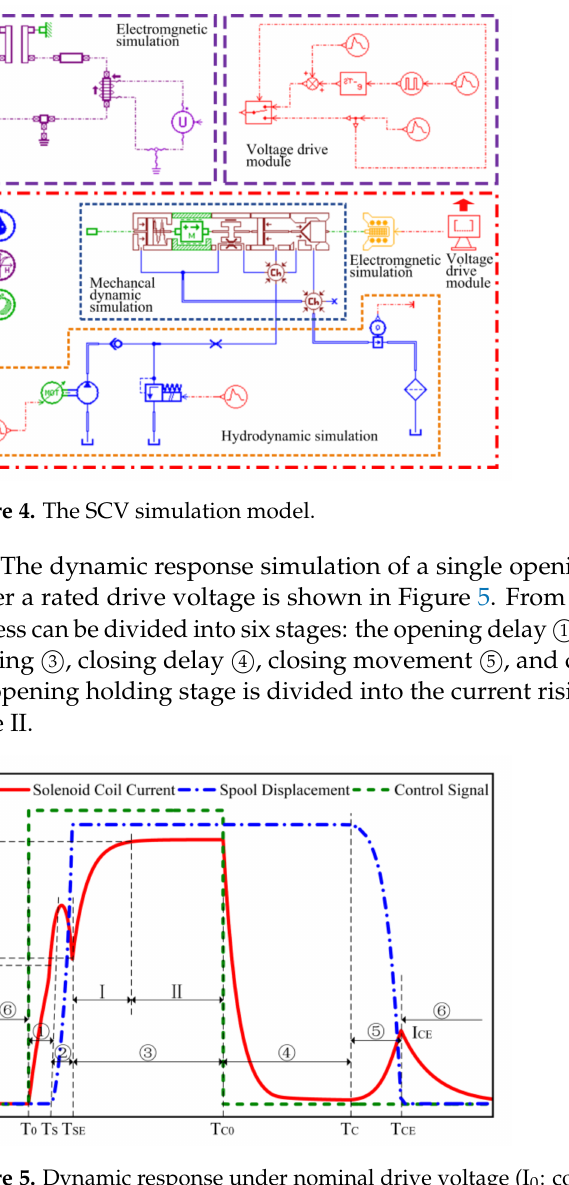
Figure 5. Dynamic response under nominal drive voltage (I 0 : coil current without voltage